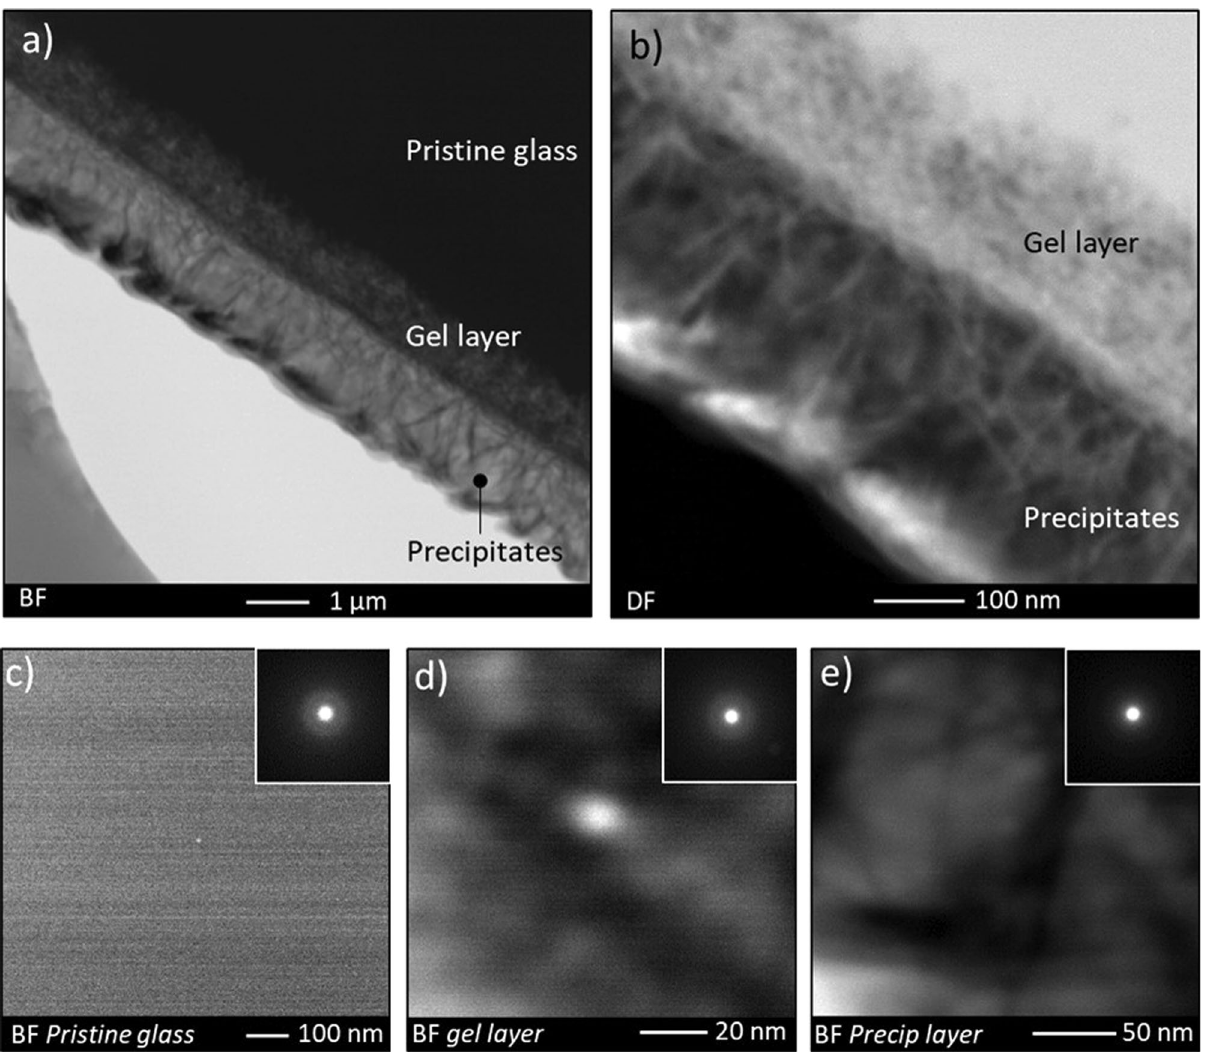
Fig. 7 Scanning transmission electron microscopy analysis of CaZn28 glass after 84 d of dissolution in Old Cement Water. a Bright fi eld image showing the cross section of the pristine glass, gel layer and precipitate layer; ( b ) dark fi eld micrograph of the gel layer sandwiched between the pristine glass and ribbon-like precipitates; and high resolution bright fi eld images and associated selective area electron diffraction patterns of: ( c ) the pristine glass; ( d ) the gel layer; and ( e ) the precipitates.